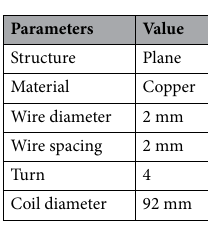
Table 2. The Parameters of the coil